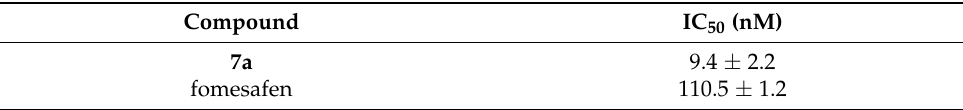
Table 4. The inhibitory activity of compound 7a against Nt